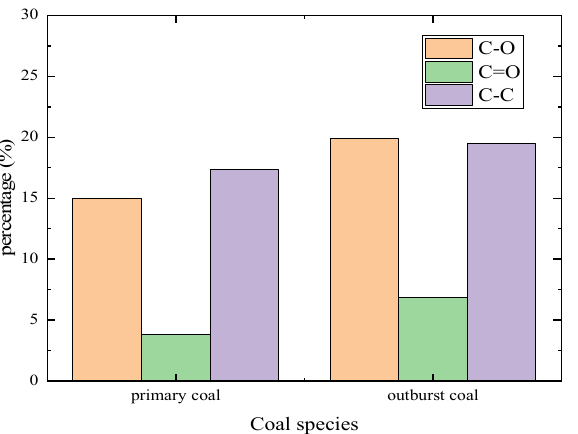
Figure 6. Statistical distribution histogram of oxygen-containing functional groups’ structure content.